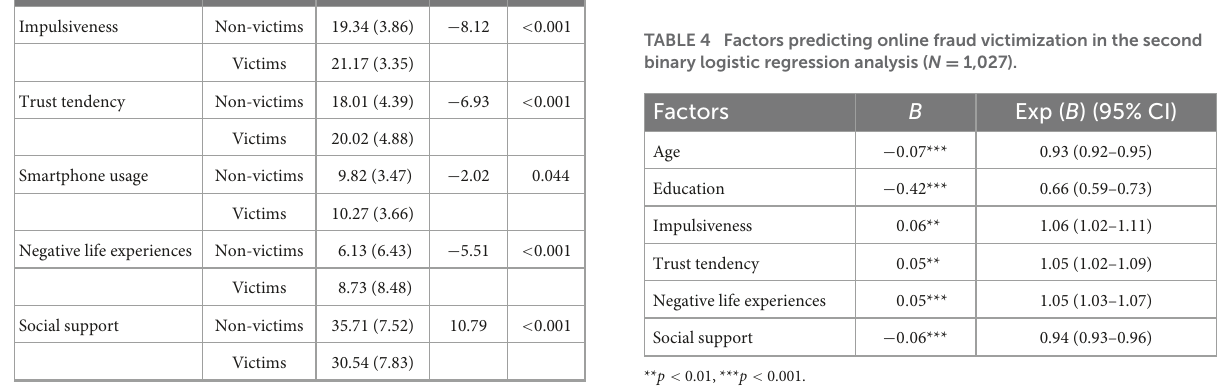
TABLE 2 Differences between victims and non-victims in social-psychological variables ( N = 1,027).